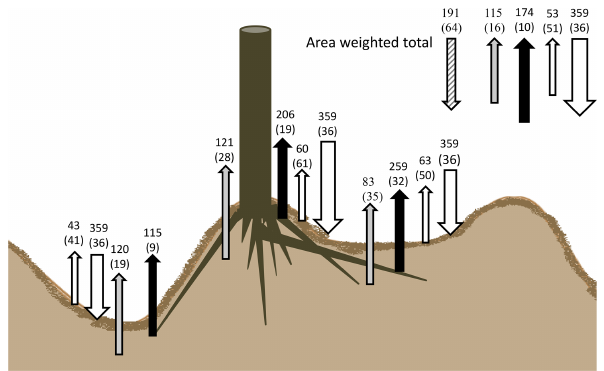
Figure 8. Summary of soil C budget (in gCm − 2 yr − 1 ) under the canopy of a Sitka spruce and lodgepole pine plantation on deep peat. Downward arrows indicate litterfall, whilst upward fluxes show au- totrophic ( F a ) (black), peat decomposition flux (grey) and surface needle litter (white) across the three main microforms. Total forest soil fluxes with area-weighted values are visualized in the top-right corner, including the estimated soil C sink (grey and white diagonal